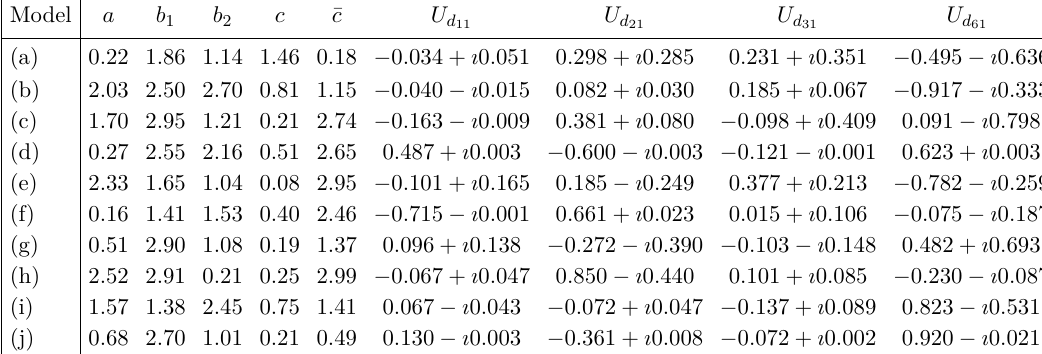
A numerical estimate of the elements of the down Higgs zero mode eigenvector using the analysis of table 1 and the couplings of eq. (2.3).